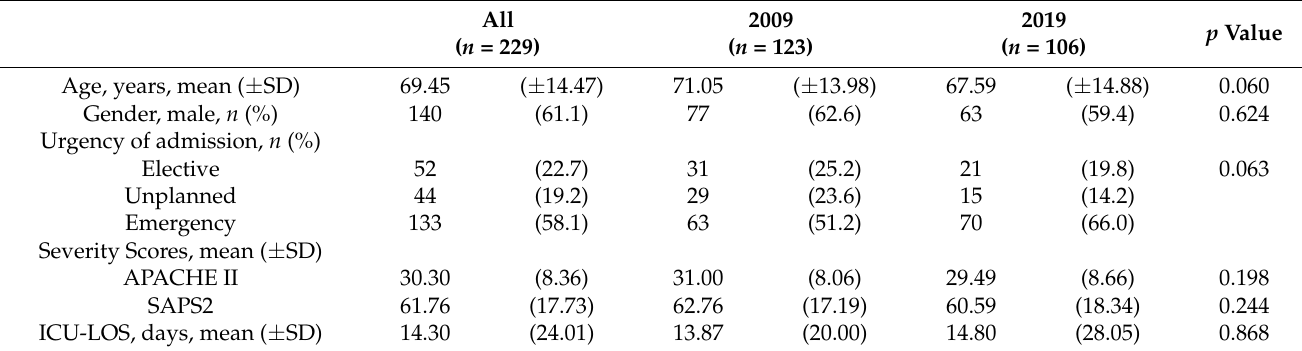
Table 1. Patient